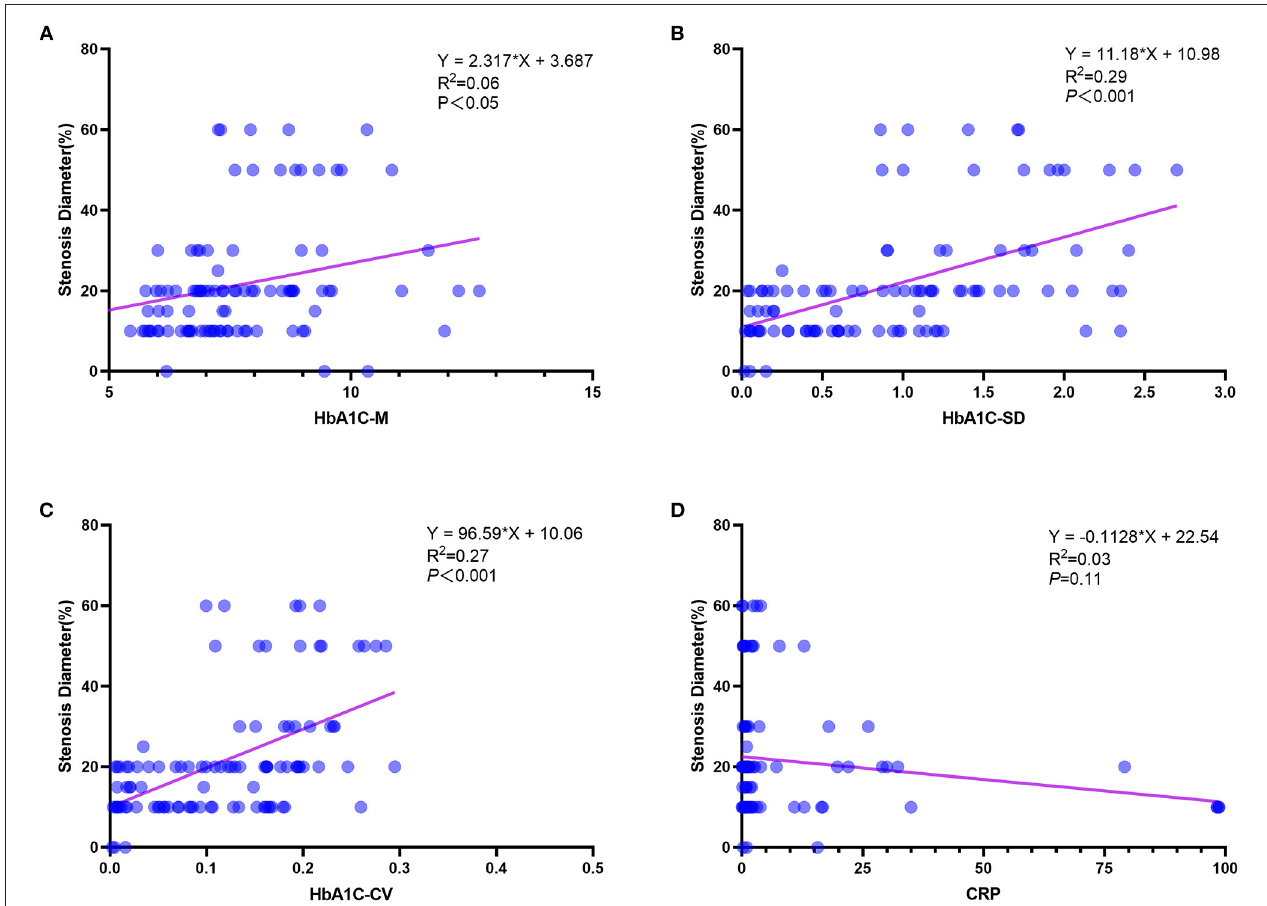
FIGURE 5 | The association between different predictors and the rate of DES-ISR. (A) The correlation analysis between HbA1c-M and the rate of DES-ISR. (B) The correlation analysis between HbA1c-SD and the rate of DES-ISR. (C) The correlation analysis between HbA1c-CV and the rate of DES-ISR. (D) The correlation analysis between CRP and the rate of